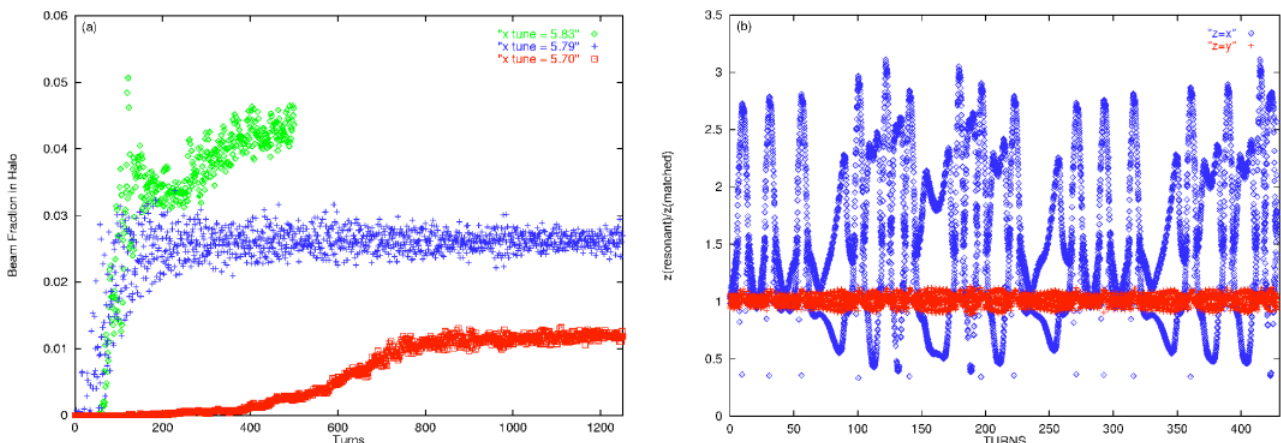
FIG. 14. (Color) Excitation of resonances by space charge: (a) Fraction of the beam in the halo versus turns for mismatched doublet PIC calculation with horizontal tune n x (cid:1) 5.85 and vertical tunes n y (cid:1) 5.70 (red), 5.79 (blue), and 5.83 (green); (b) ratio of horizontal (blue) and vertical (red) envelope amplitudes to those of matched beam for PCM for initially numerically matched beam in doublet lattice with n x (cid:1) 6.035 and n y (cid:1) 5.885